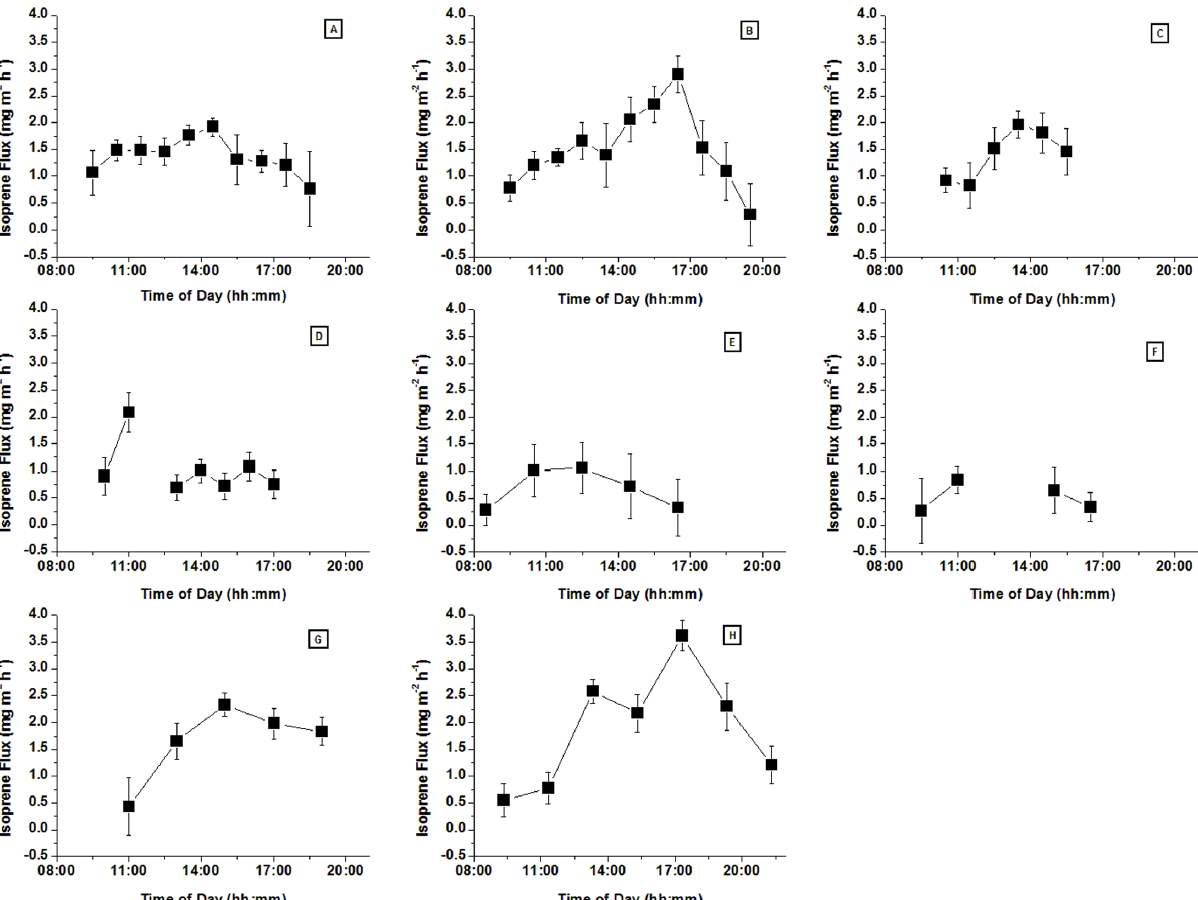
Fig. 4. Isoprene fluxes (mgm − 2 h − 1 ) measured during the CABINEX 2009 campaign via DEA during the same eight intensives. Again, data represent time averages flux over the DEA measurement cycle and the tower footprint. Error bars represented the propagated uncertainty associated with each flux measurement data